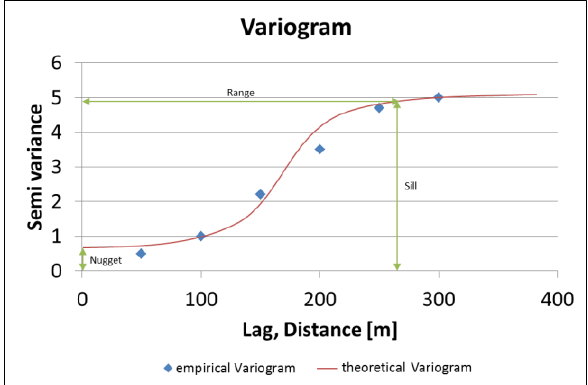
Figure 3. Approximate values for nugget, sill, and range in the variogram function (fig. from Laun,